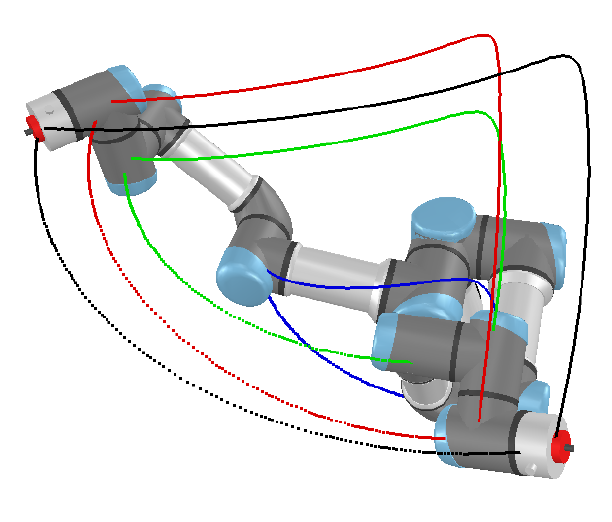
Figure 10. Comparision of movej (dotted line) and PSO optimized (solid line) joints and tool centre point (TCP) trajectories; elbow is represented by blue color, wrist joints with red and green and TCP trajectory is depicted with black